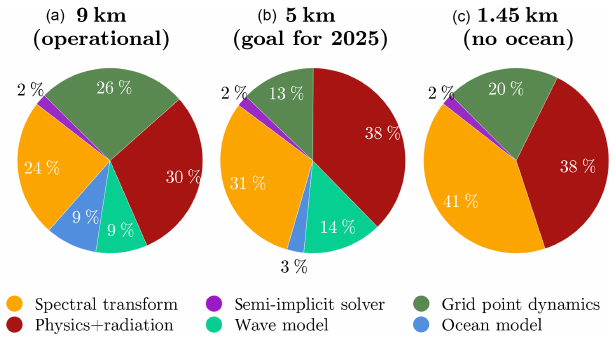
Figure 3. Cost profiles of the significant components of the IFS NWP model in percent of CPU time at the operational 9km hori- zontal resolution with 137 vertical levels (a) , the anticipated future horizontal resolution of 5km with 137 vertical levels (b) , and an experimental resolution of 1.45km with 62 vertical levels (c) . The grid point dynamics represents the advection and grid point compu- tations related to the dynamical core, the semi-implicit solver rep- resents the computations and communications internal to spectral space, spectral transform relates to the communications and compu- tations in the transpositions from grid point to spectral and reverse as well as the FFT and DGEMM computations (see also spectral transform schematic below), physics + radiation relates to the cost of physical parametrisations including radiation, and finally the ad- ditional components of the wave and ocean models are accounted for but nonetheless excluded in the 1.45km simulation. All of these profiles have been obtained through measurements on ECMWF’s Cray XC40